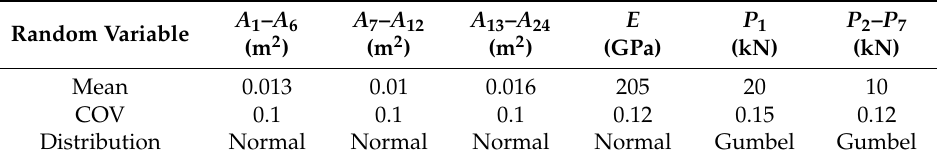
Table 2. Random variables for dam truss example.